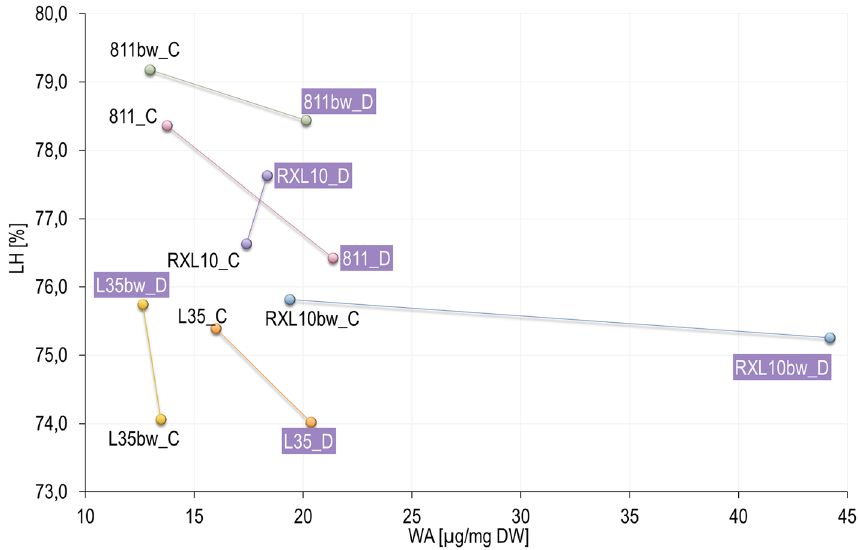
Figure 2. Changes in the mean percentage of flag leaf hydration (LH) and wax amount (WA) of near-isogenic glaucous (811, L35, RXL10) and non-glaucous (811bw, L35bw, RXL10bw) rye lines that constitute pairs 811/811bw, L35/L35bw, and RXL10/RXL10bw, under control (C) and drought conditions (D). Drought-treated objects are marked with purple